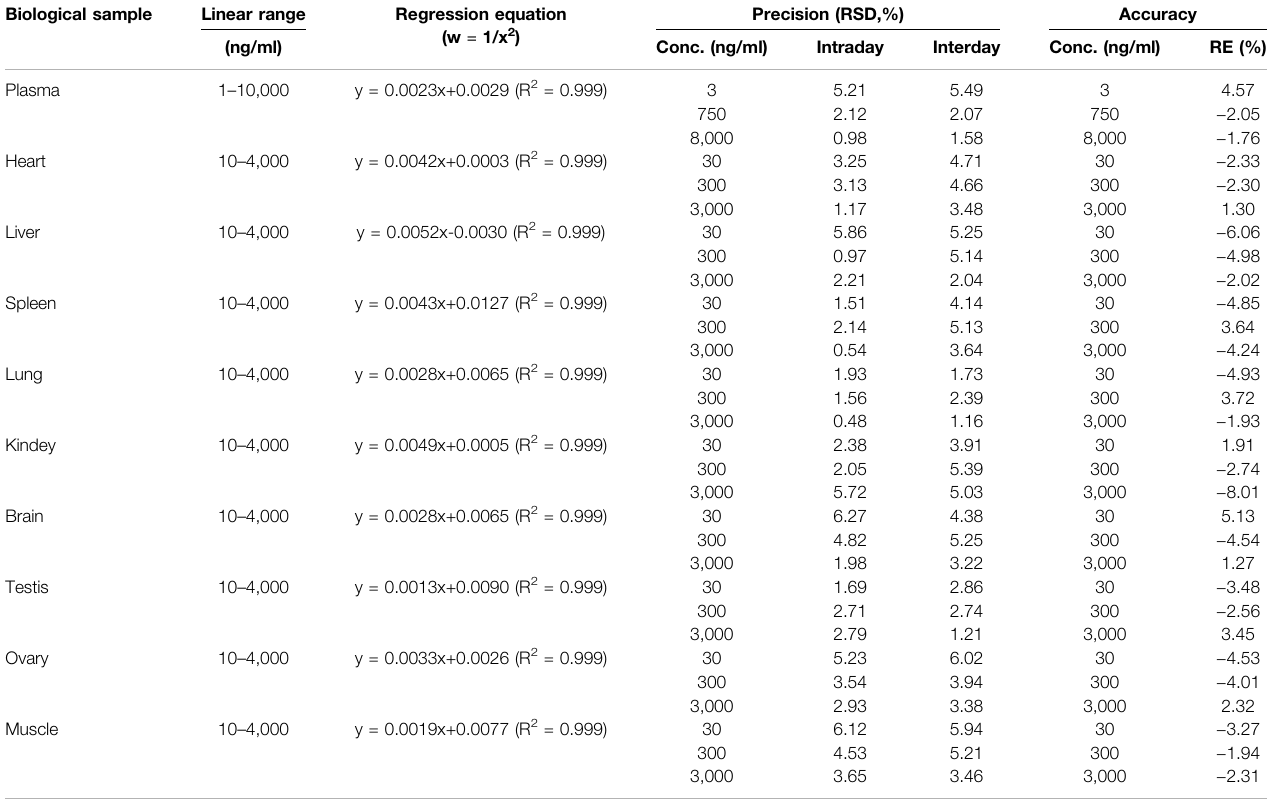
TABLE 1 | Precision and accuracy of the assay method for DF in biological sample ( n (cid:1) 5). Biological sample